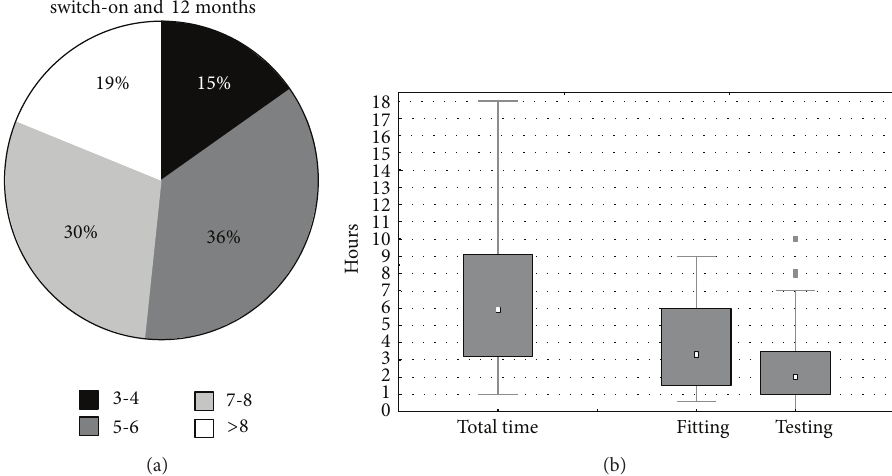
Figure 4: Time analysis of the follow-on sessions during the first year after switch-on, showing the number of sessions (pie chart at the left) and the cumulative time spent at them (box and whisker plots at the right), both the total time and its breakdown into time spent at fitting and at testing. Time for counseling has not been enquired in this study. See caption of Figure 1 to interpret the box and whisker plots.